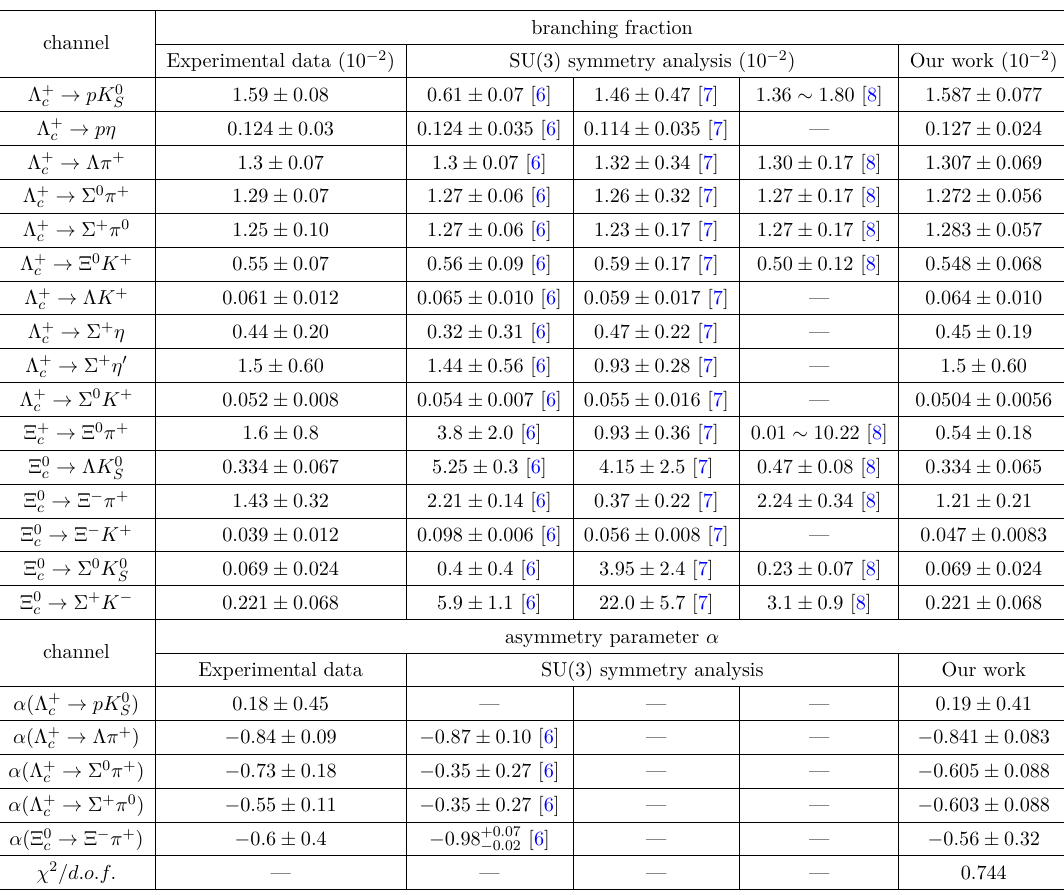
Table 3 . Experimental data on branching fractions and polarization parameters (the second col- umn), previous theoretical predictions (the third column) and our fitting results (the fourth column). predicted to be (4 . 70 ± 0 . 08) × 10 − 4 in table 1 which is much closer to data. All